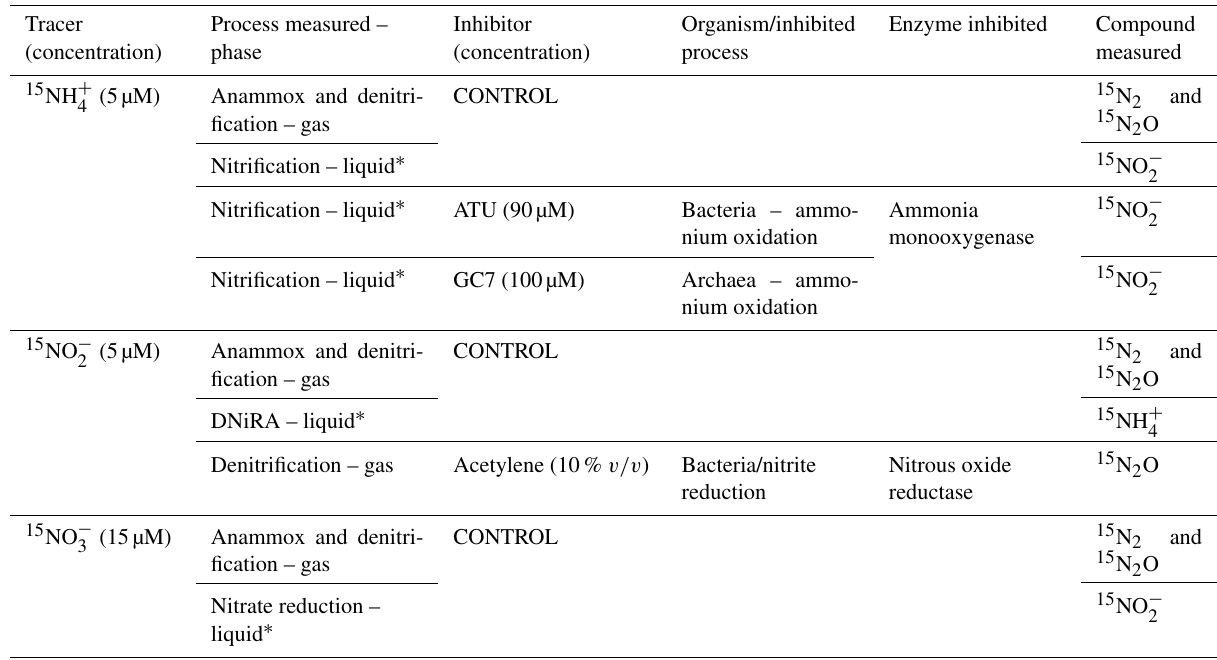
Table 1. Experimental design. Tracked N-loss process and coupled pathways by the use of 15 N substrate, with detailed of the inhibitors added. Measured 15 N products and phase are